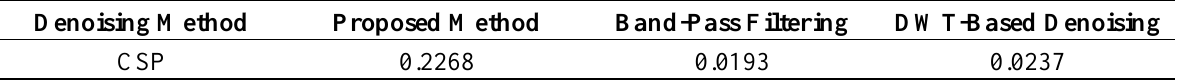
Table 2. The CSP values for the denoising results of different